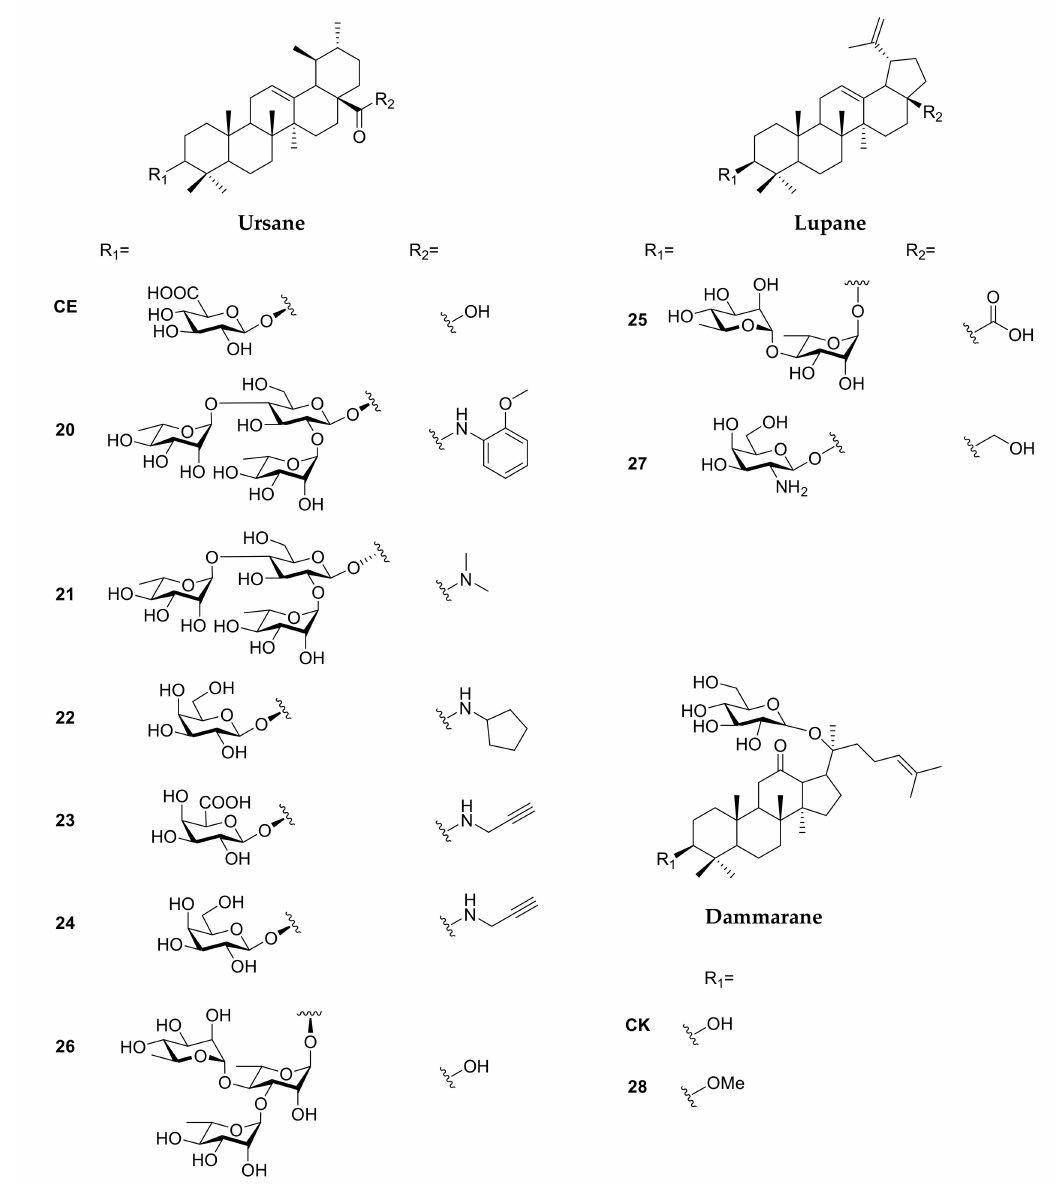
Figure 4. Synthetic saponins derived from ursane-, lupane-, and dammarane-type sapogenins. Pakulski and Strnad developed a series of lupane- (modified at 3-OH position) and homolupane-based (modified at 28-COOH position) saponins, including 3-O-glycoside, 28-COO-glycoside, 28-COO-thioglycoside, 28-COO-selenoglycoside and bidesmosidic